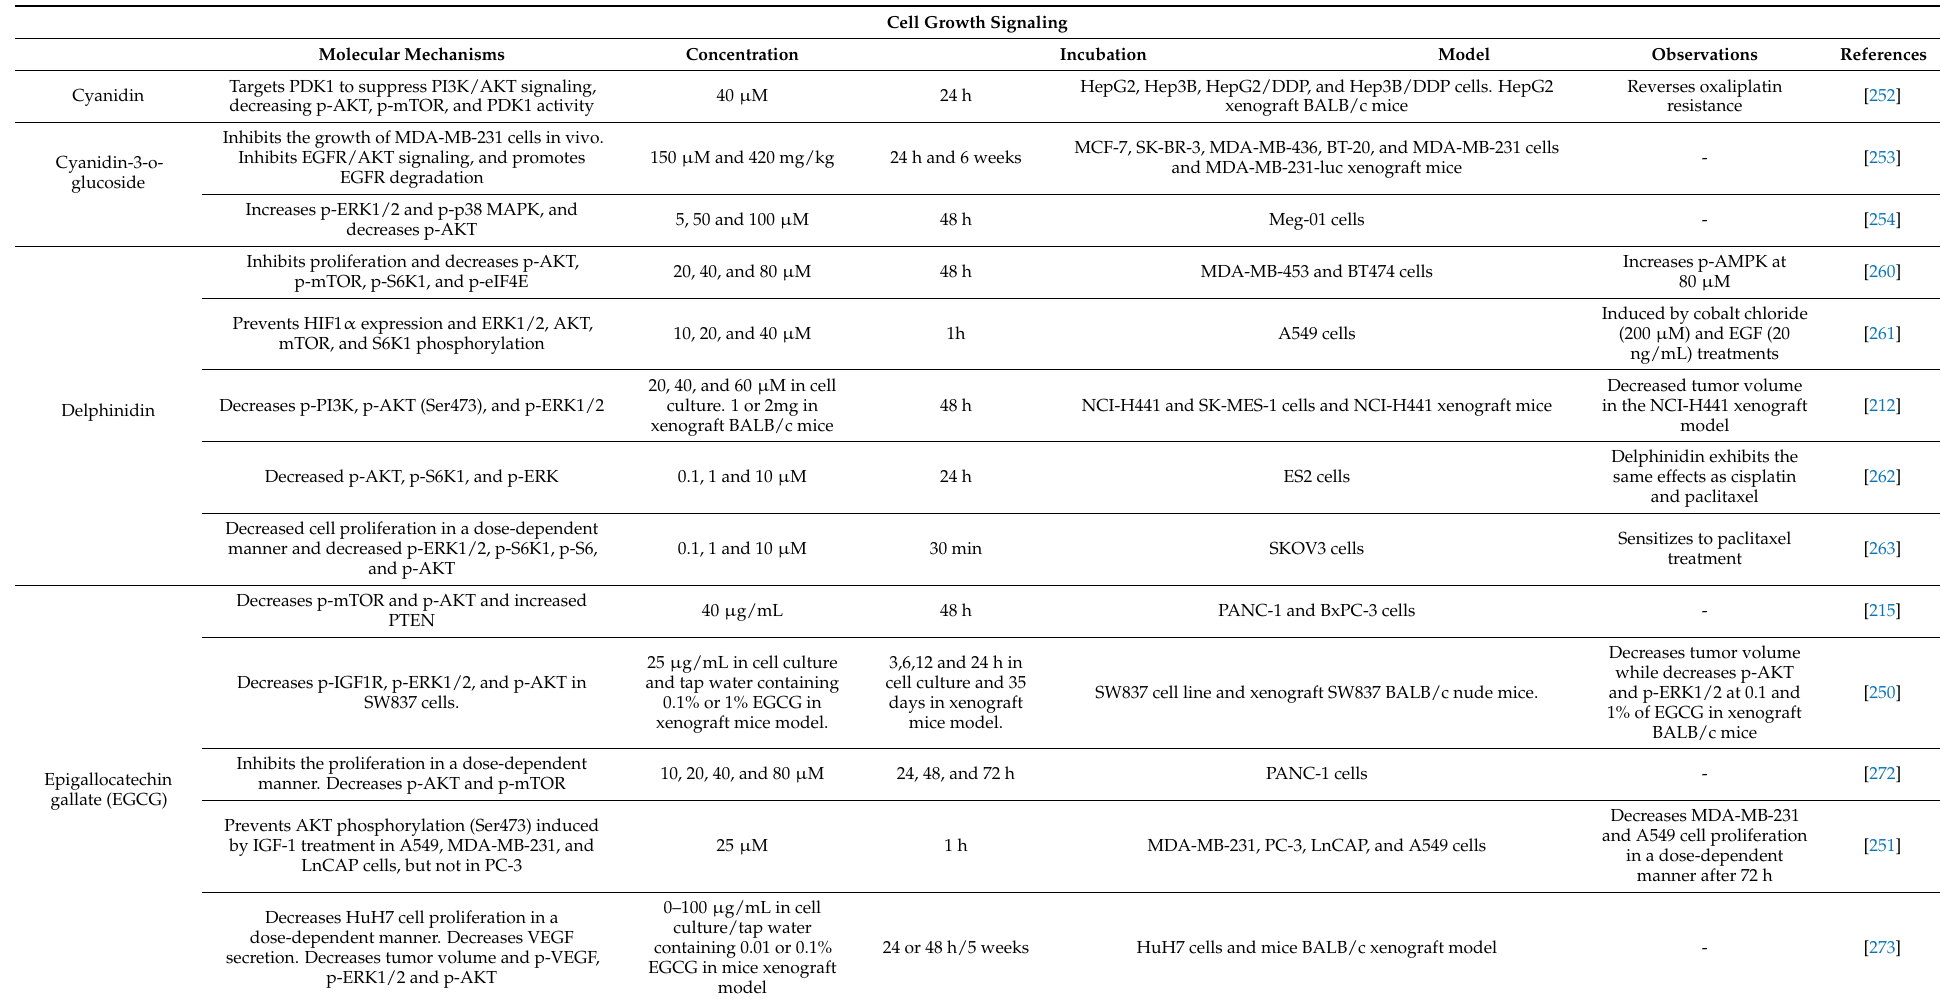
Table 5. Molecular mechanisms of flavonoids in cell growth signaling and